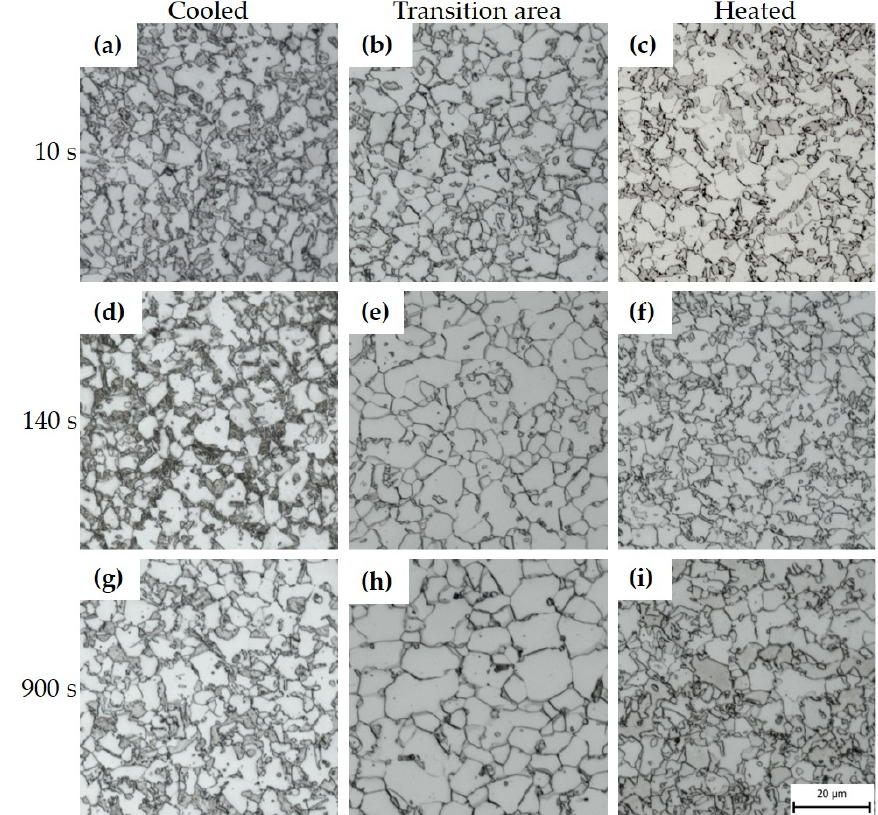
Figure 10. Microstructures of 20MnAl after hot stamping under an optical microscope: ( a ) 10s_C, ( b ) 10s_T, ( c ) 10s_H, ( d ) 140s_C, ( e ) 140s_T, ( f ) 140s_H, ( g ) 900s_C, ( h ) 900s_T, ( i ) 900s_H.